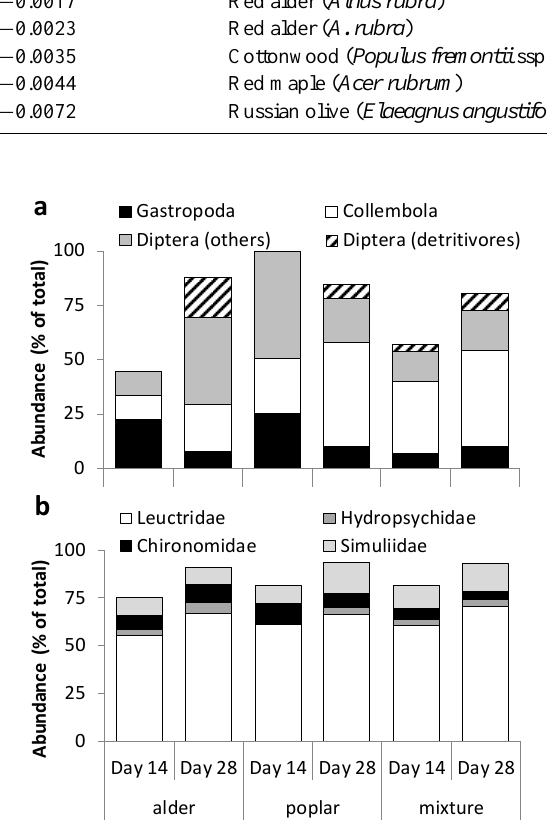
Figure 3. Relative abundance of the three most abundant taxonomic groups colonising leaves of alder, poplar and mixture decomposing (a) at the riparian zone and (b) in the stream of Ribeira do Botão. Detritivores are shown in white and stripes.